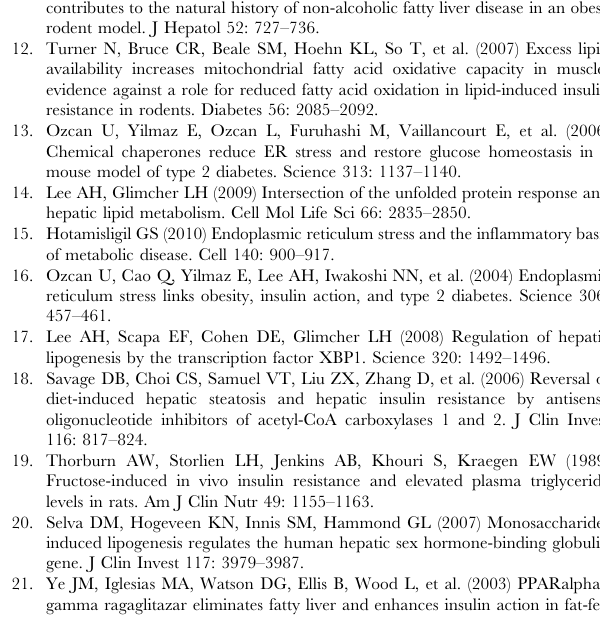
Figure S1 mRNA expression of SREBP-1c and ChREBP. After one week of HFru or HFat feeding, mRNA expression of the lipogenic transcription factors SREBP-1c ( A ) and ChREBP ( B ) was determined by RT-PCR. Data are mean fold change 6 SE relative to CH-fed mice of 6 mice per group. * p , 0.05, ** p , 0.01 vs CH. (TIF) Table S1 Specific primers for real time PCR.